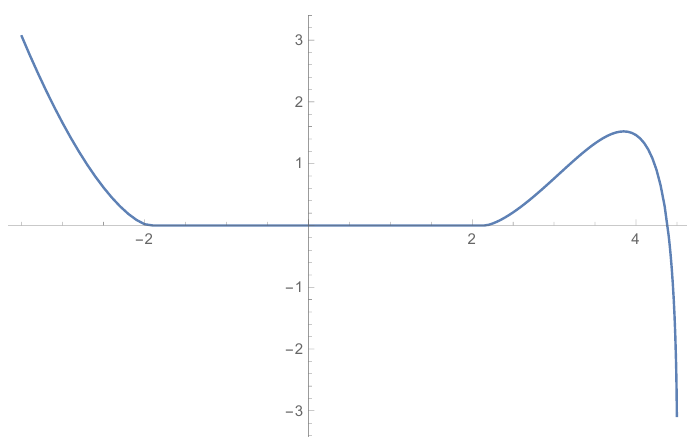
Figure 3 . The effective potential V eff ( x ) at λ = 1 / 18 , M = 16 / 100